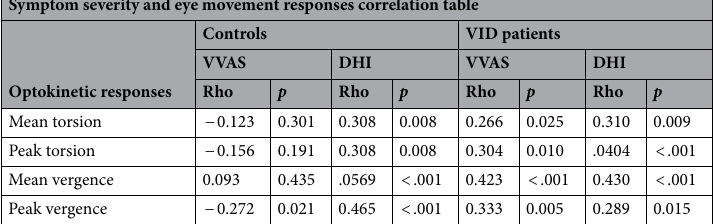
Table 1. Correlation table between slow-phase velocities for each eye movement and the Visual Vertigo Analogue Scale (VVAS) and Dizziness Handicap Inventory (DHI) for both healthy participants and patients suffering from visually induced dizziness